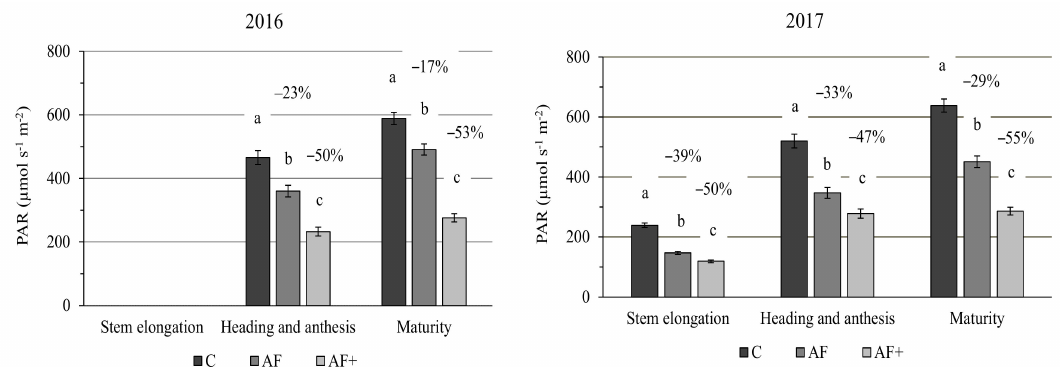
Figure 1. Photosynthetic active radiation (PAR; µ mol s − 1 m − 2 ; mean ± S.E.) recorded in three treatments (C = Control, AF = yearly pruned olive grove, AF+ = never pruned olive grove) during 2015–16 ( left ) and 2016–17 ( right ) wheat-growing seasons at stem elongation (from sowing to 7 April), heading and anthesis (from 8 April to 10 May), and maturity (from 11 May to harvesting). Numbers above histograms indicate the percentage variation as compared to controls within each wheat cycle period. Within the same period and year, different letters indicate significant differences according to the Tukey’s HSD test ( p ≤